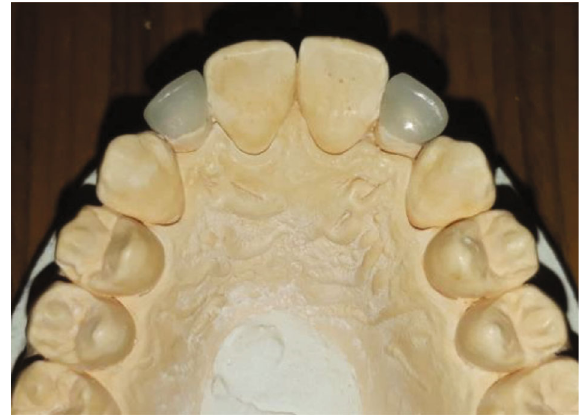
Figure 7: Milled three-quarter crowns.